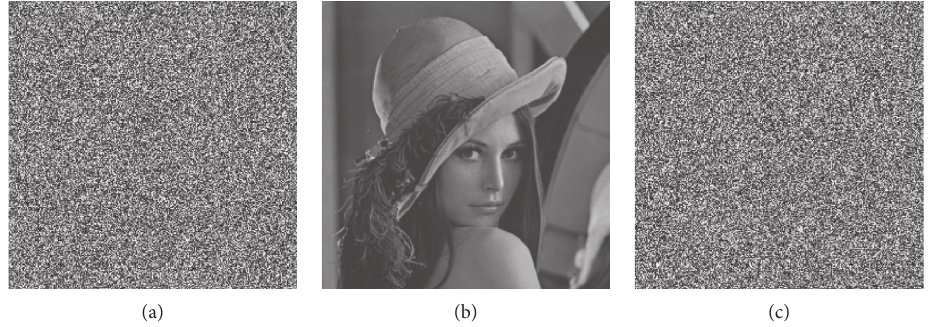
Figure 9: Key sensitivity evaluation. (a) The cipher image. (b) The image decrypted with the correct keys. (c) The image decrypted with a slightly different key. Table 2: Pearson’s correlation coefficient between two images. Image